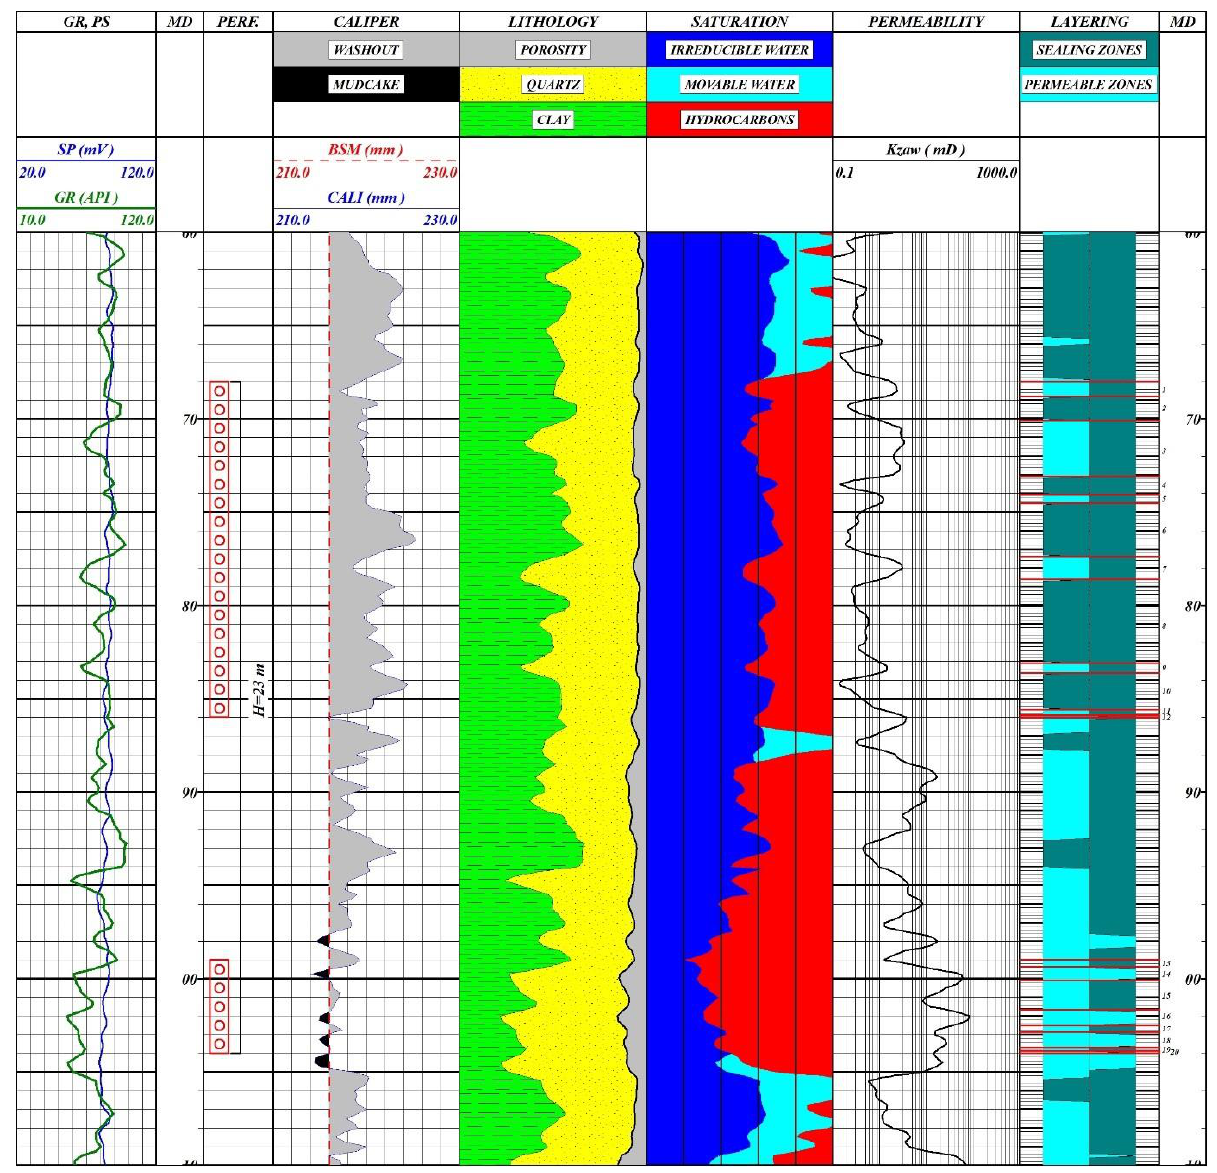
Figure 9. Results of the interpretation of the permeability changes profile within the analysed perforation intervals in the P-6 well.